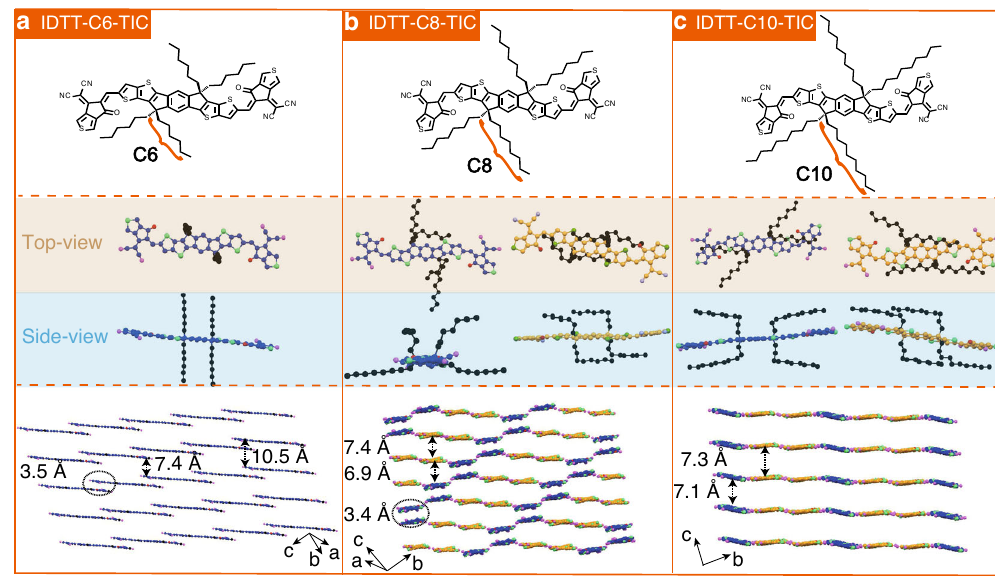
Fig. 1 Molecular and single crystal structure of IDTT-CX-TIC. a – c The chemical structure and crystal packing of IDTT-CX-TIC with plane to plane distances. In IDTT-C6-TIC, hexyl side chains take a fully extended geometry that stretching out from the conjugated backbone. In IDTT-C8-TIC, octyl side chains adopt a random extension without structure order and crankshaft-type side chain extension. In IDTT-C10-TIC, octyl side chains adopt harpoon type and crankshaft-type side chain extensions. The molecular backbones with different types of side chain extension are marked by blue and yellow color. C6, C8, and C10 represent n -hexyl, n -octyl, and n -decyl side chains,